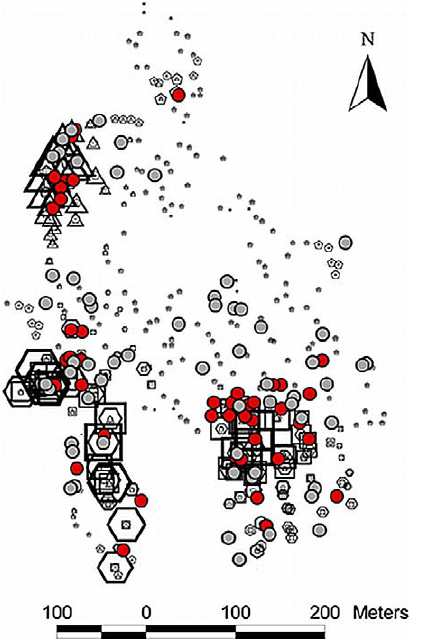
Figure 3. Estimated geographic position of introductions of Trypanosomacruzi into the community of Guadalupe, Arequipa, Peru. The probability that each household was the first (hexagons), second (triangles), third (squares) or fourth (pentagons) site of introduction under the four-epicenter model is shown. Larger shapes correspond to higher probabilities. Households with cases of human disease are shown as red circles, and those with vectors carrying T. cruzi are shown in grey circles. The following steps were taken to protect patient anonymity in making this map: The geographic position of human cases has been slightly and randomly perturbed; the positions of some uninfected households have been altered; and certain regions of the map have been rotated a random angle around their